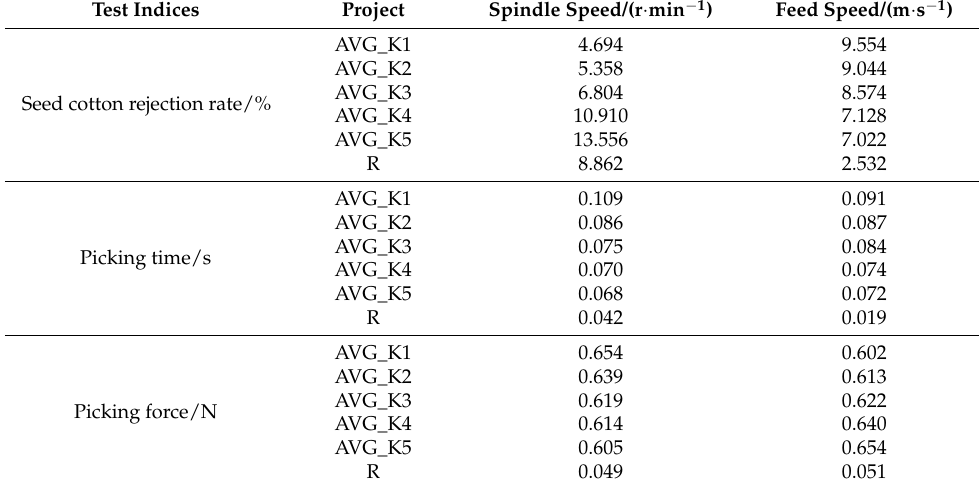
Table 3. Range analysis of test